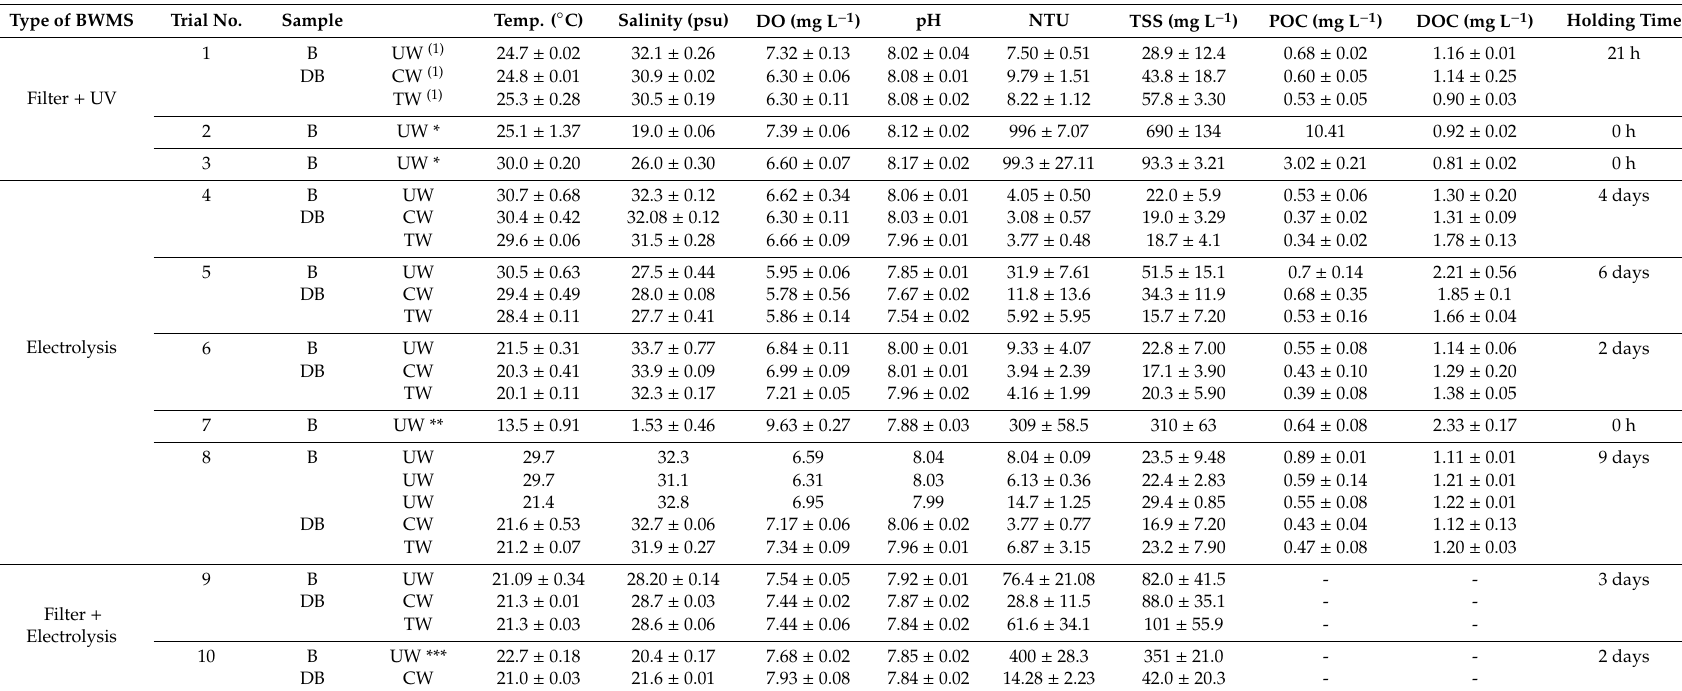
Table 4. Environmental condition observed during the testing for three types of BWMS installed on